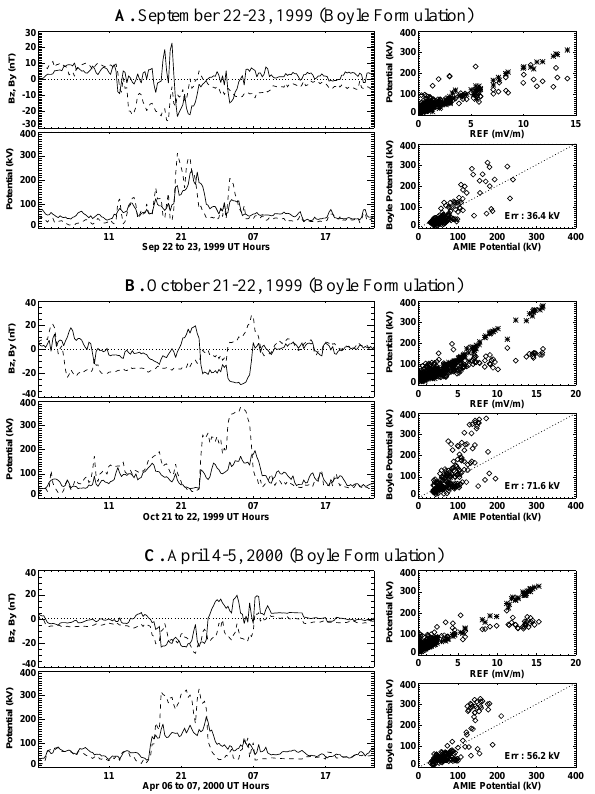
Fig. 2. Three more events in the same format as Figure 1.